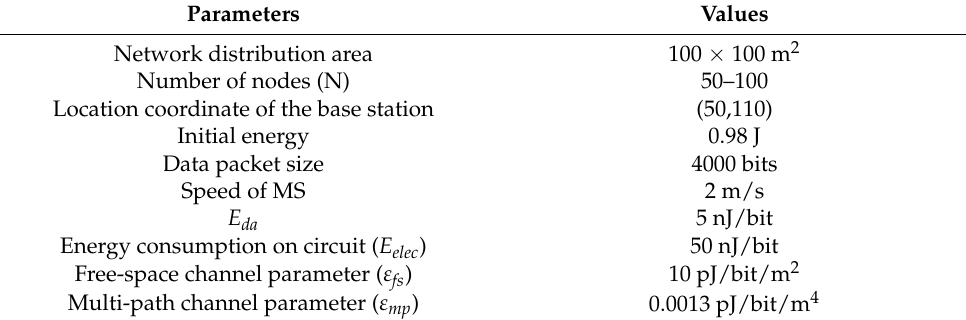
Table 2. The boundary conditions of network.